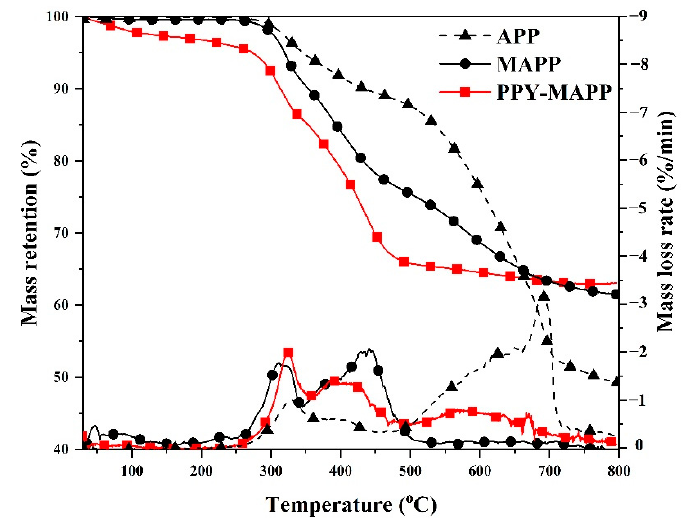
Figure 4. TG and DTG curves of APP and MAPP and PPy-MAPP.